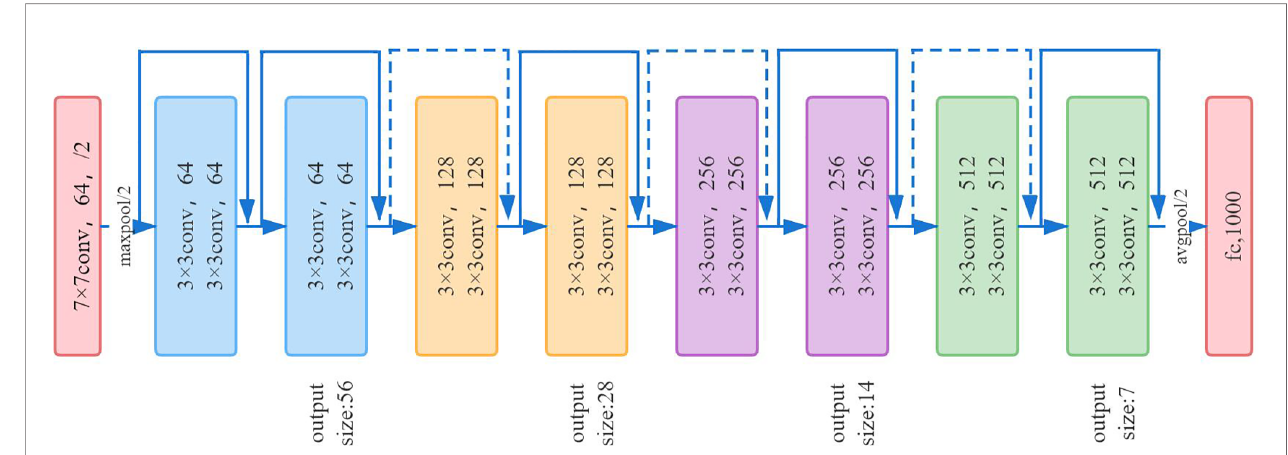
FIGURE 6 | The network architecture of